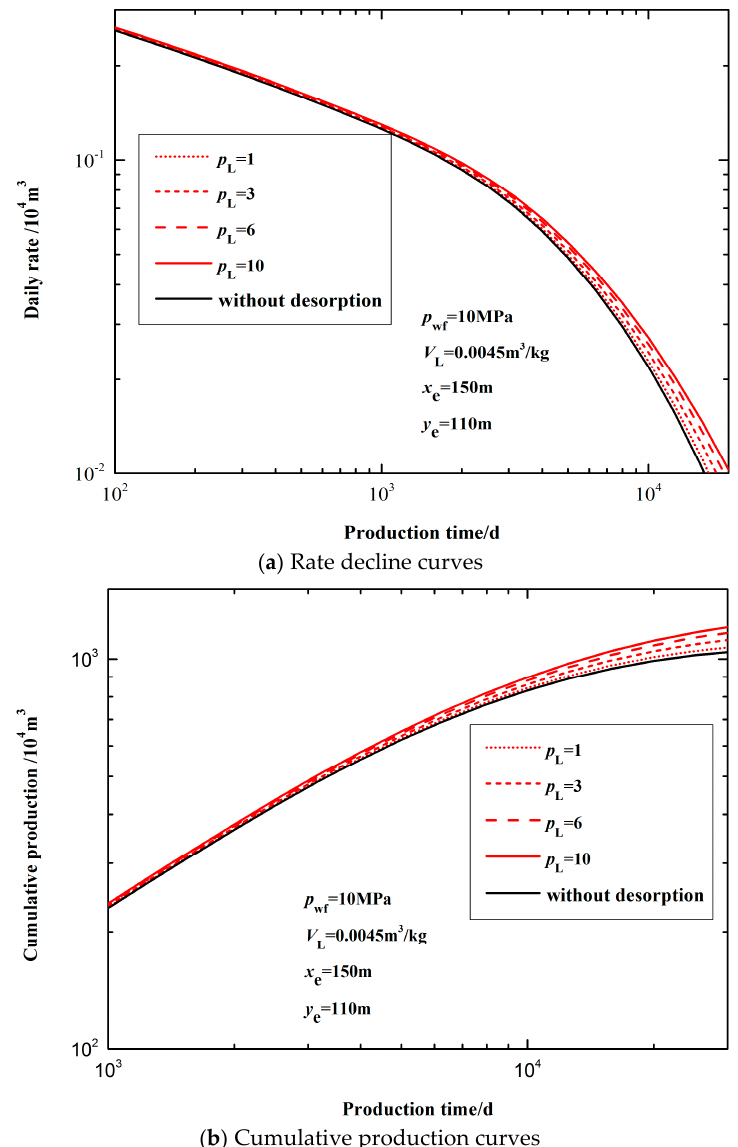
Figure 11. Effects of Langmuir pressure value on production behavior.